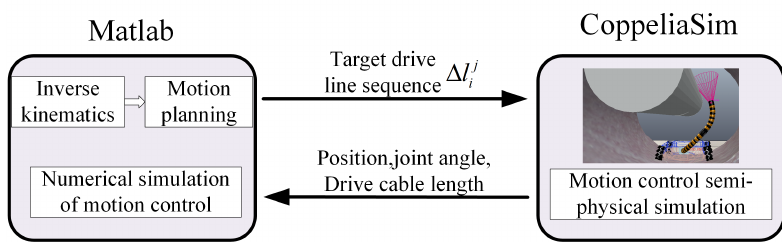
Figure 9. The scheme of the motion control simulation